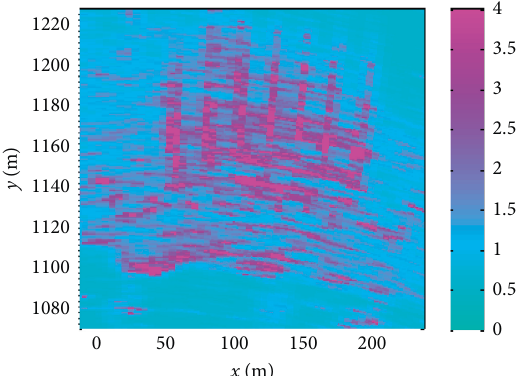
Figure 7: Distribution of phase stability of the dam.